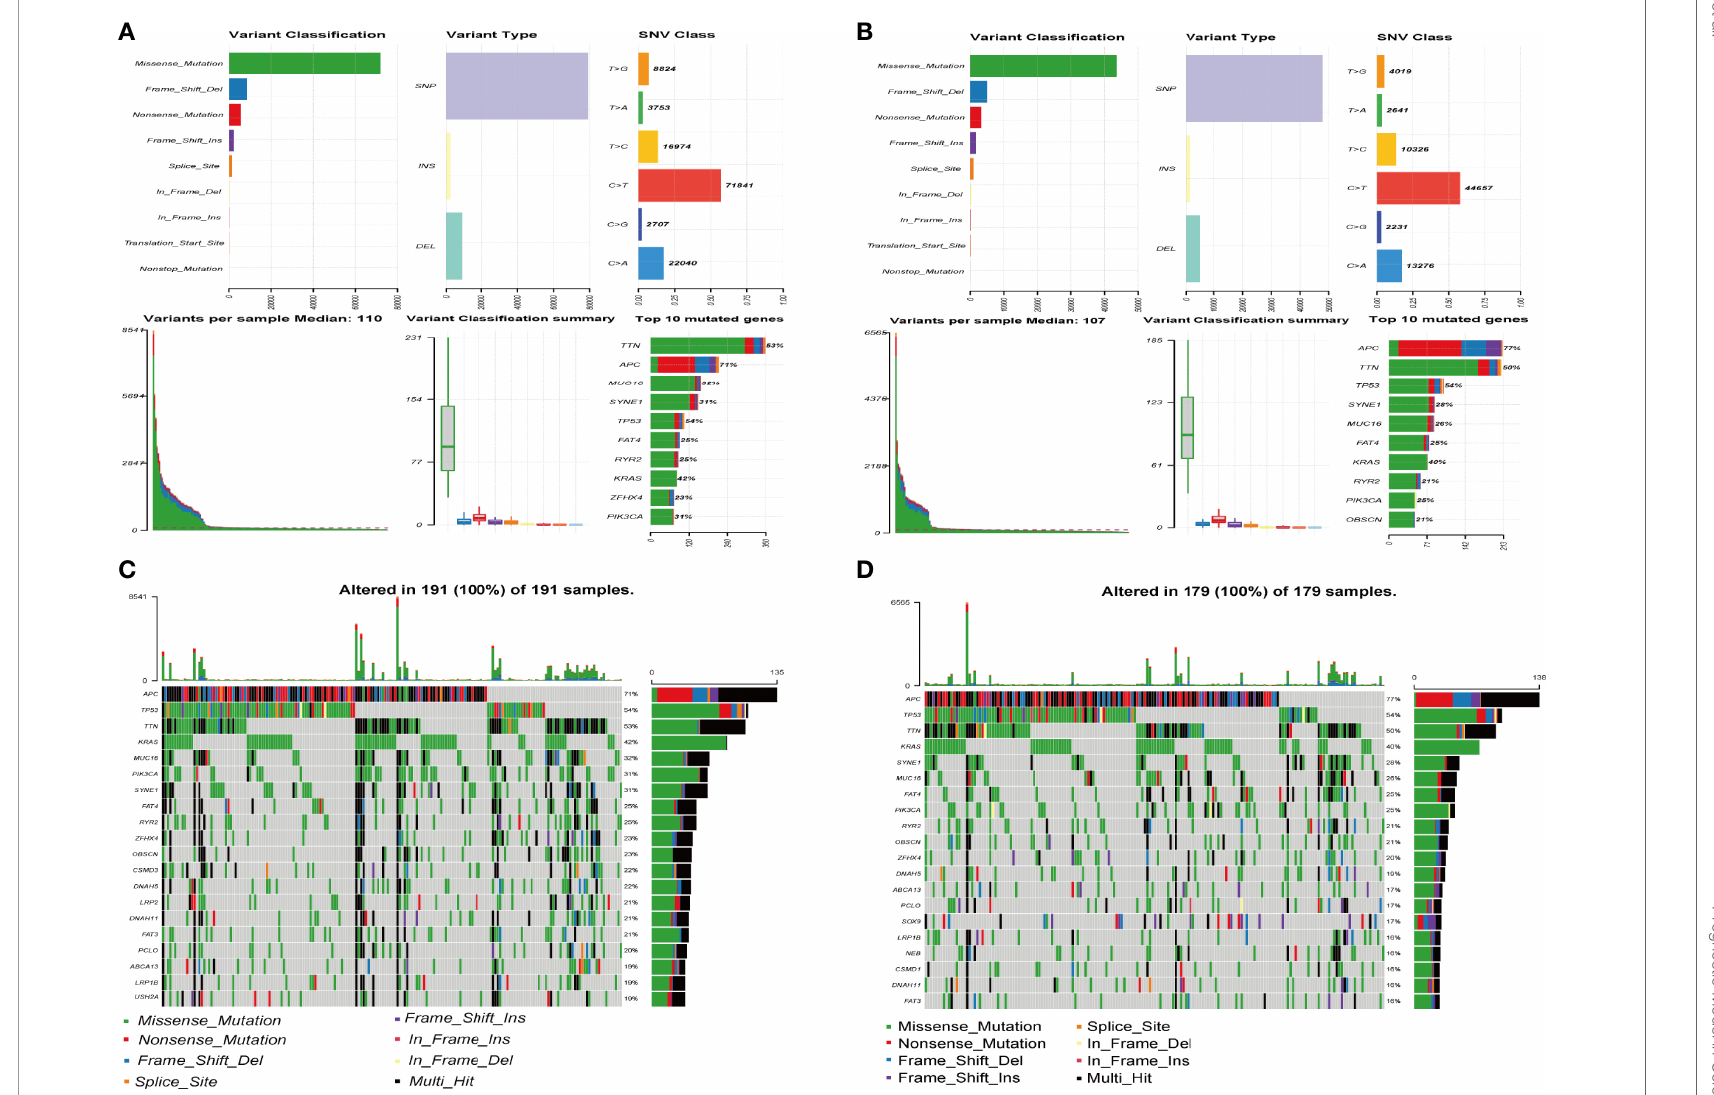
FIGURE 8 | Mutation information of mutated genes between high- and low-risk groups. (A, B) The distribution of different types of mutations between the high-risk (A) and low-risk groups (B) . The upper represents variant classi fi cation, variant type, SNV (single nucleotide variants) class of mutated genes, the blow represents variants per sample, variant classi fi cation, top 10 mutated genes. (C, D) Waterfall plot of the top 20 mutated genes in the high-risk (C) and low-risk groups (D) . The gene mutation patterns for each sample are displayed in the middle panel. The upper bar plot depicts the total mutation burden of each sample. The mutation frequencies for each gene are shown in the right